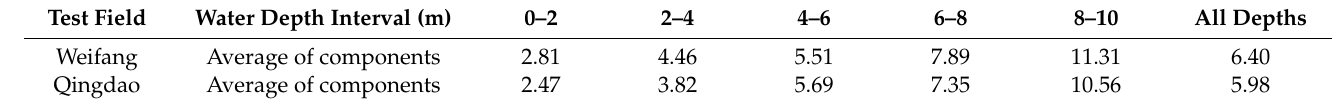
Table 2. Average numbers of waveform components at various water depths for the two test